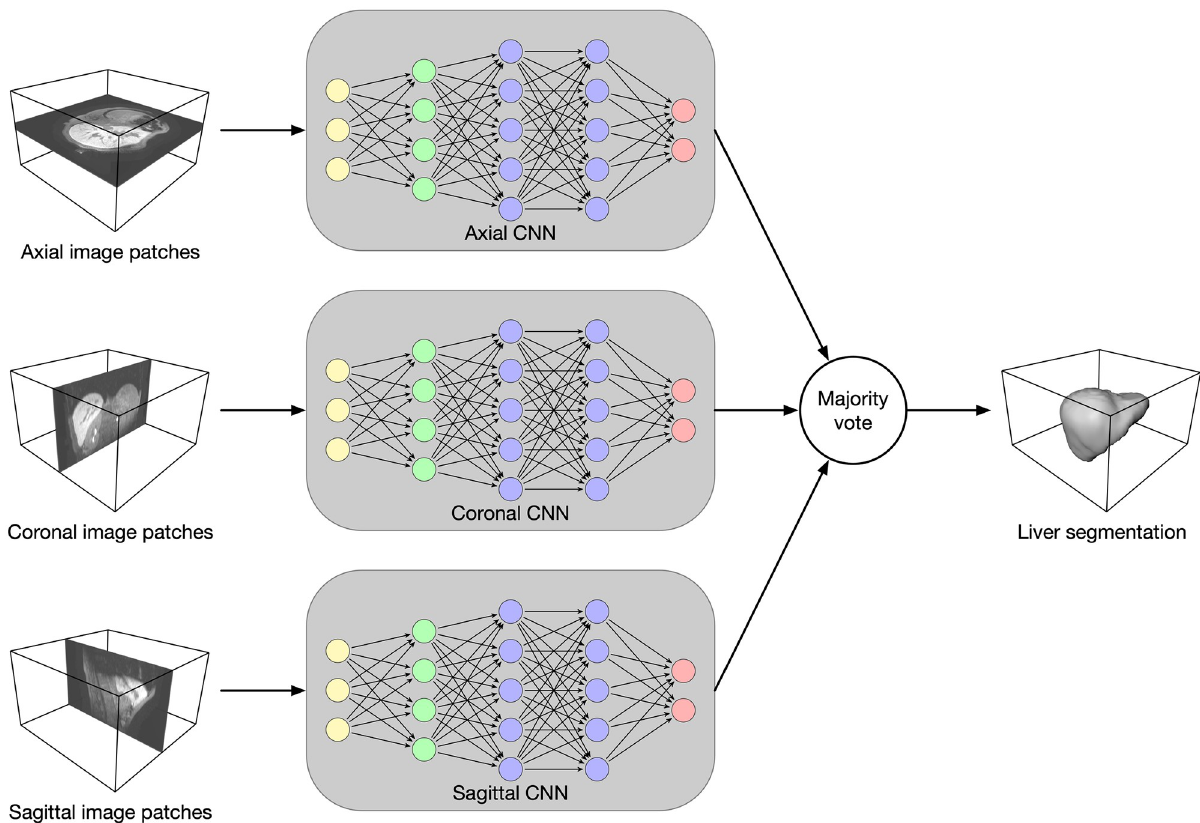
Fig 1. Overview of the Liver-Net method. Three 2D U-net-like models analyze axial, coronal and sagittal image patches. The final segmentation mask is obtained by a majority vote.